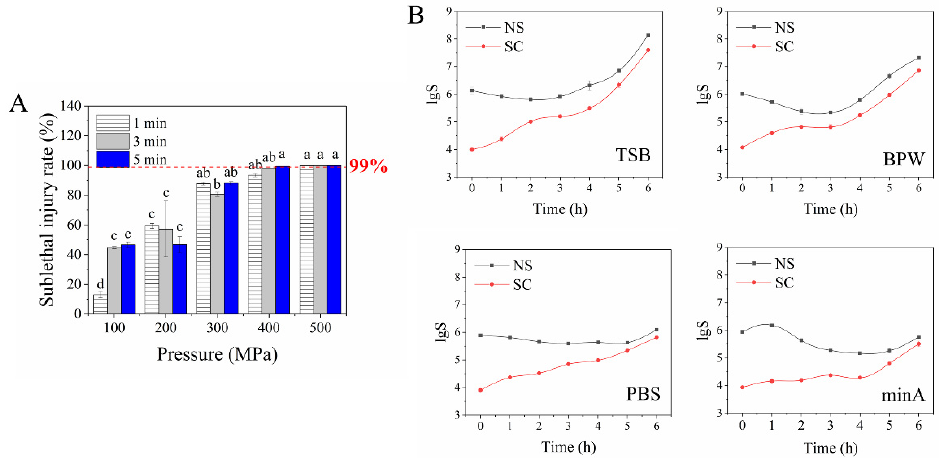
Figure 1. The sub-lethal injury rate ( A ) and the repair of sub-lethal E. coli O157: H7 in TSB, BPW, PBS, and minA mediums ( B ). Letter a–d in ( A ) indicate statistically significant within the groups treated with different pressures and same time ( p ≤ 0.05, Duncan